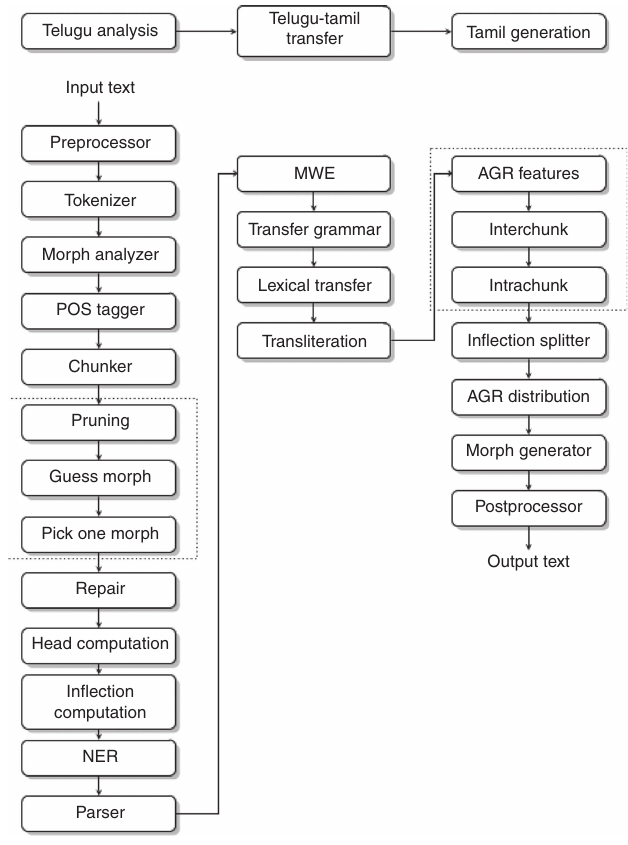
Figure 1: Telugu-Tamil MT